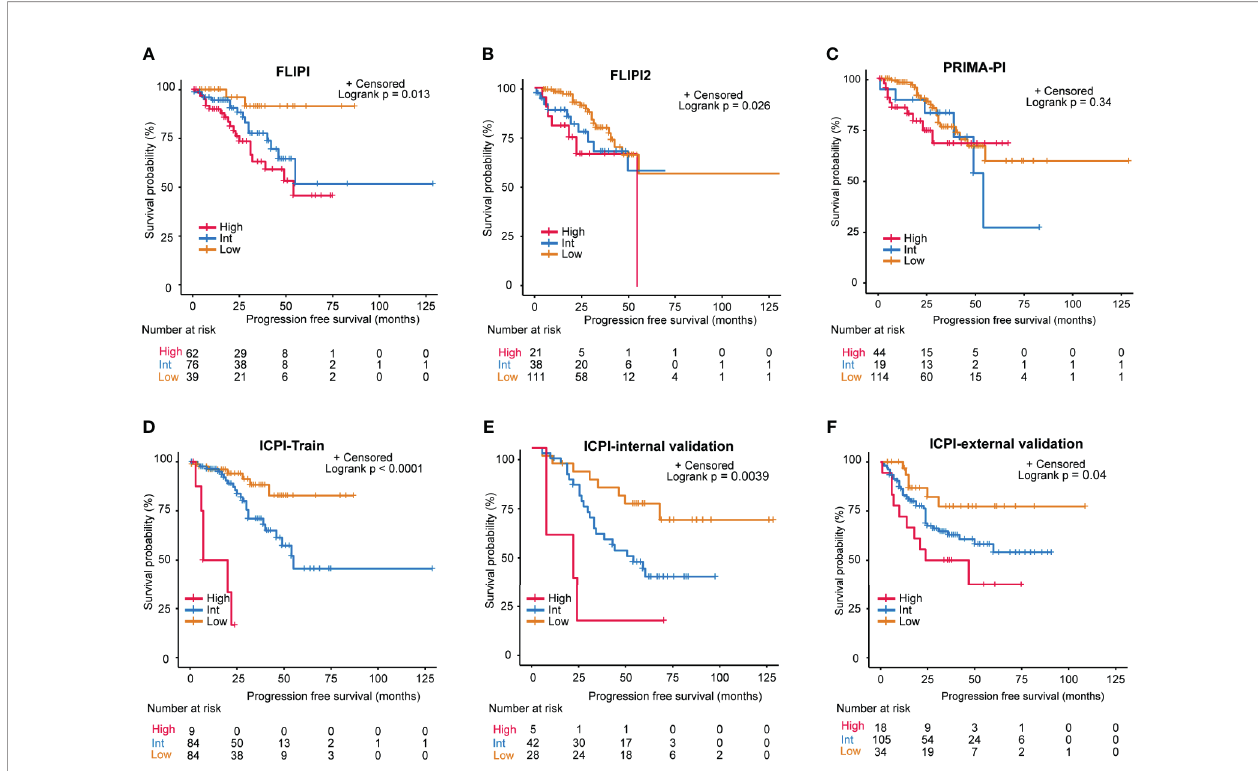
FIGURE 4 | Progression-free survival (PFS) for risk groups de fi ned by 4 scoring systems. (A) FLIPI, (B) FLIPI2, (C) PRIMA-PI, (D) Training set of the ICPI, (E) Internal validation set of the ICPI, (F) External validation set of the